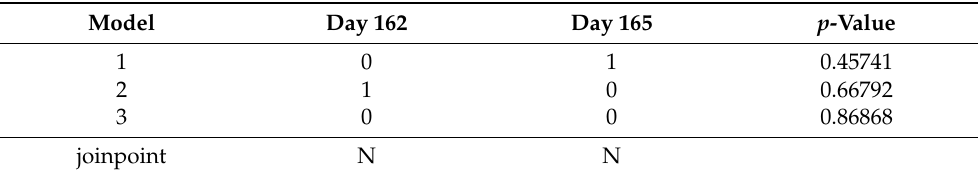
Table A2. Multiple comparisons of the effective reproduction number accounting for the absence of dates of specific events of interventions and the identification of joinpoints during the second wave of coronavirus disease 2019 in Osaka,